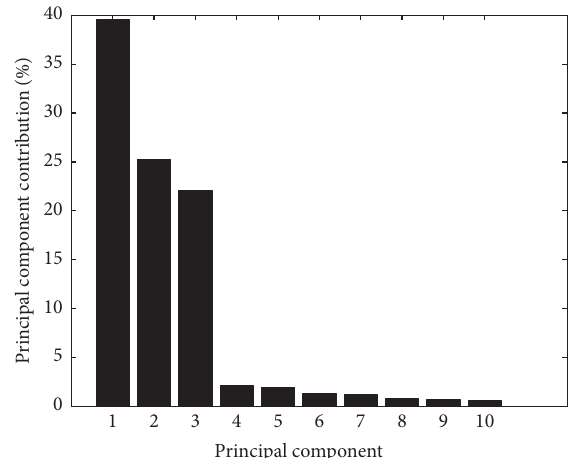
Figure 3: The first ten principal component contributions.